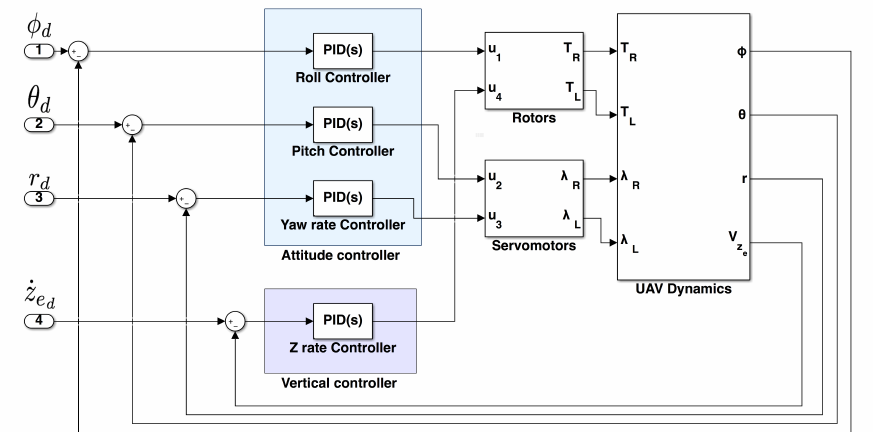
Figure 6. Attitude and vertical speed controller scheme of the UAV